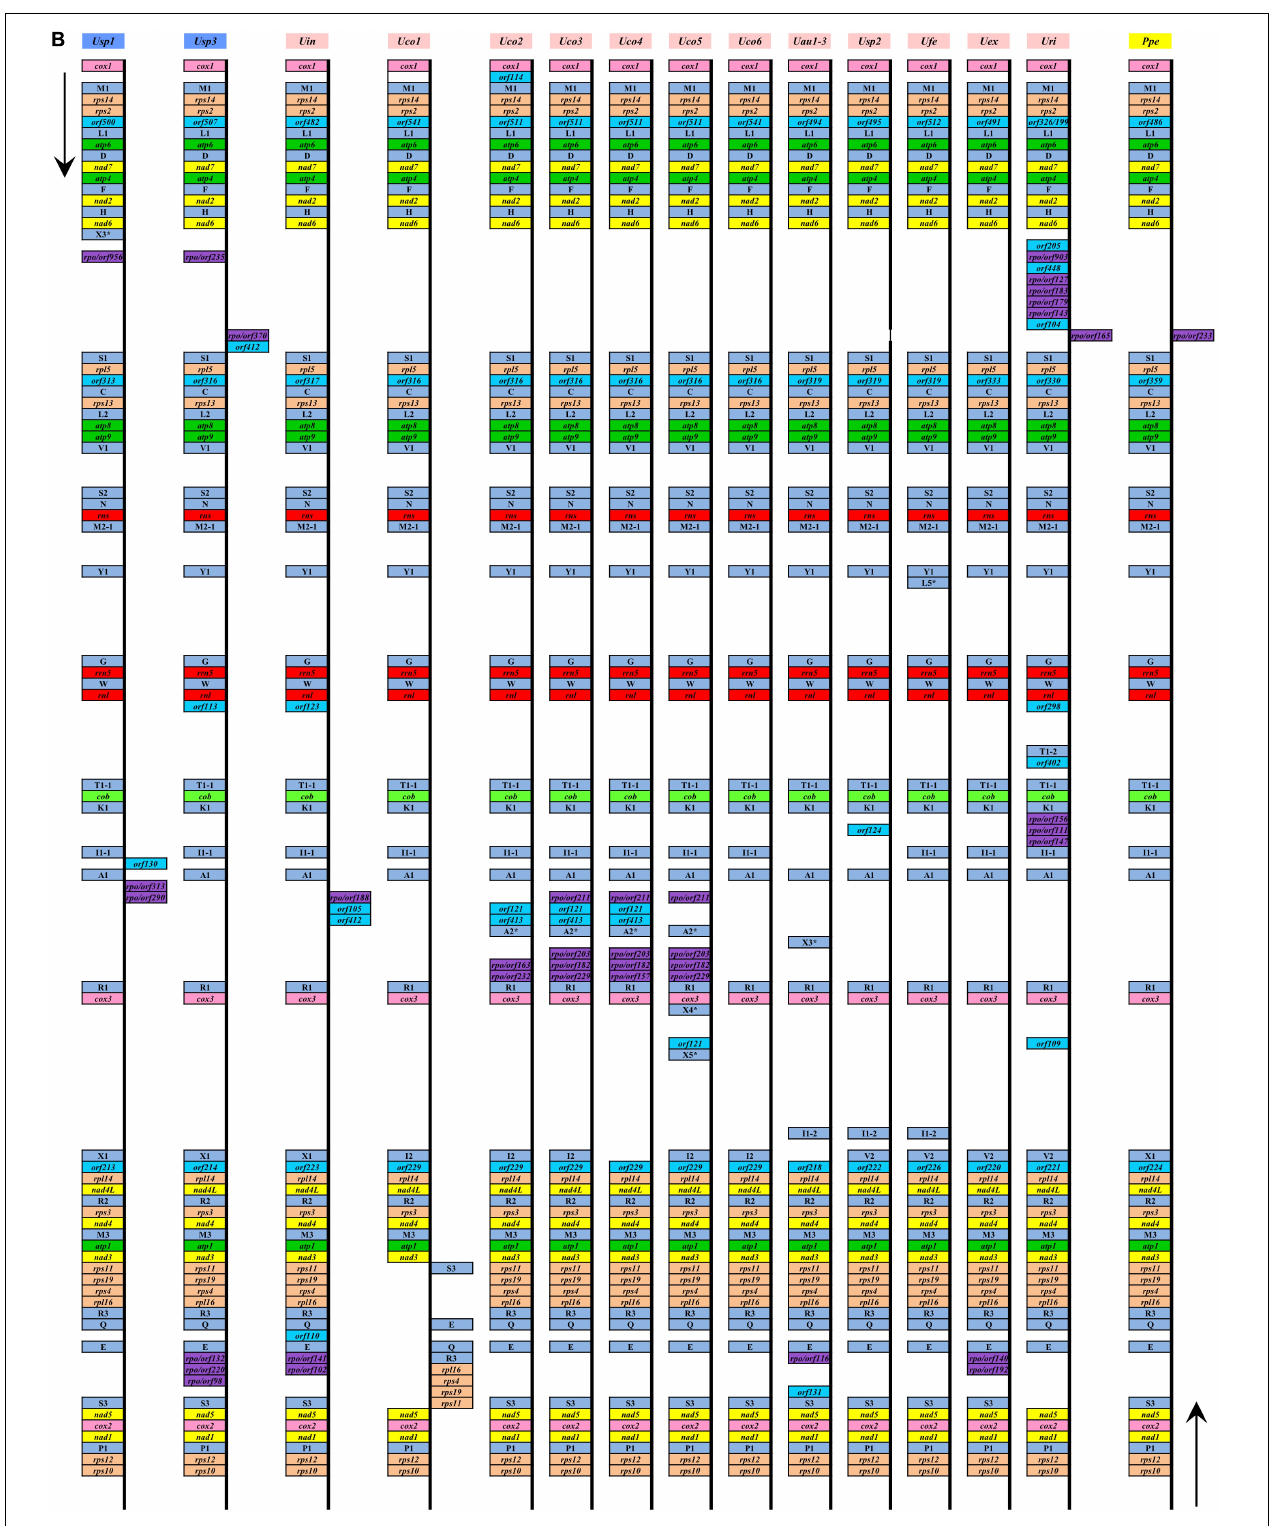
FIGURE 1 | Comparison of genome organization and gene order of these 33 sequenced ulvalean mitochondrial genomes (A,B) . The arrows indicated the direction of gene transcription. Different gene types were shown as filled boxes in different colors.